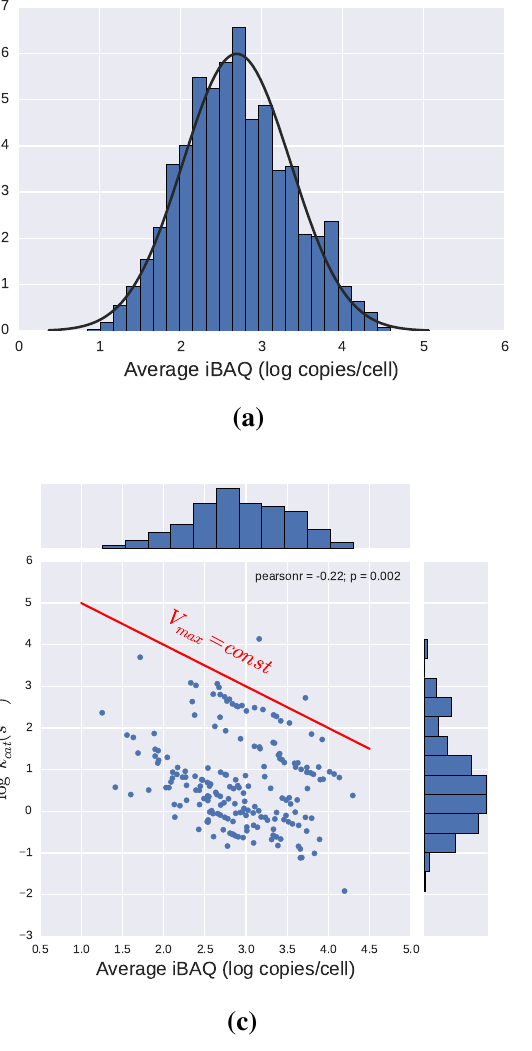
Figure 5. ( a ) Distribution of enzyme abundance in E. coli in copies/cell [40]; ( b ) Values of k for different enzymes. Bimodal distribution with modes 2.5 and 230 s − 1 ; ( c ) Values cat vs. copies per cell for different enzymes. In logarithmic coordinates, the product of k cat k E , is a straight line, so a red line has been added as a reference. All enzymes falling cat T in a line parallel to it have the same V ; ( d ) Distribution of V . Bimodal distribution max max with modes approx 1 and 75 µ M/s. Some histograms are complemented by Gaussian kernel density estimations performed using Python’s package